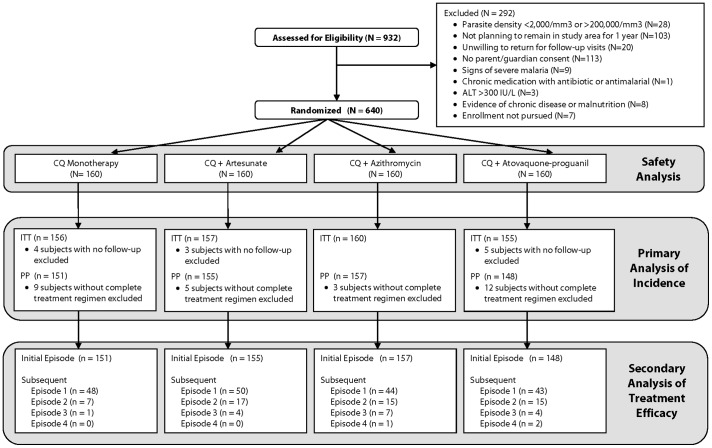
Consort Diagram.